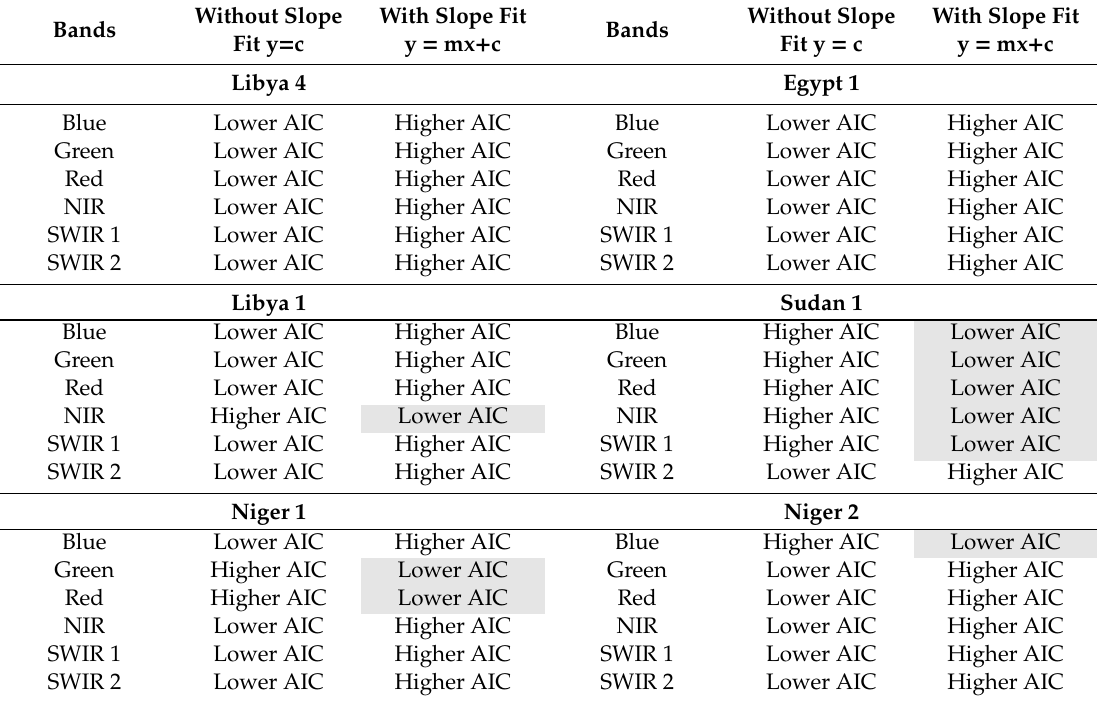
Table 16. Goodness of fit based on AIC score of Chi-Square test for the fits—without slope (y = c) and with slope (y = mx +